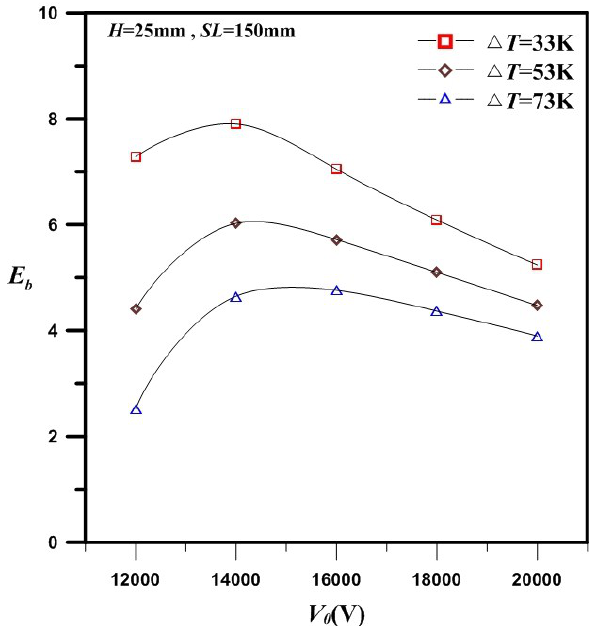
Figure 15. Variations in E b versus applied voltages V 0 for different temperature differences Δ T ( H = 25 mm and SL = 150 mm).